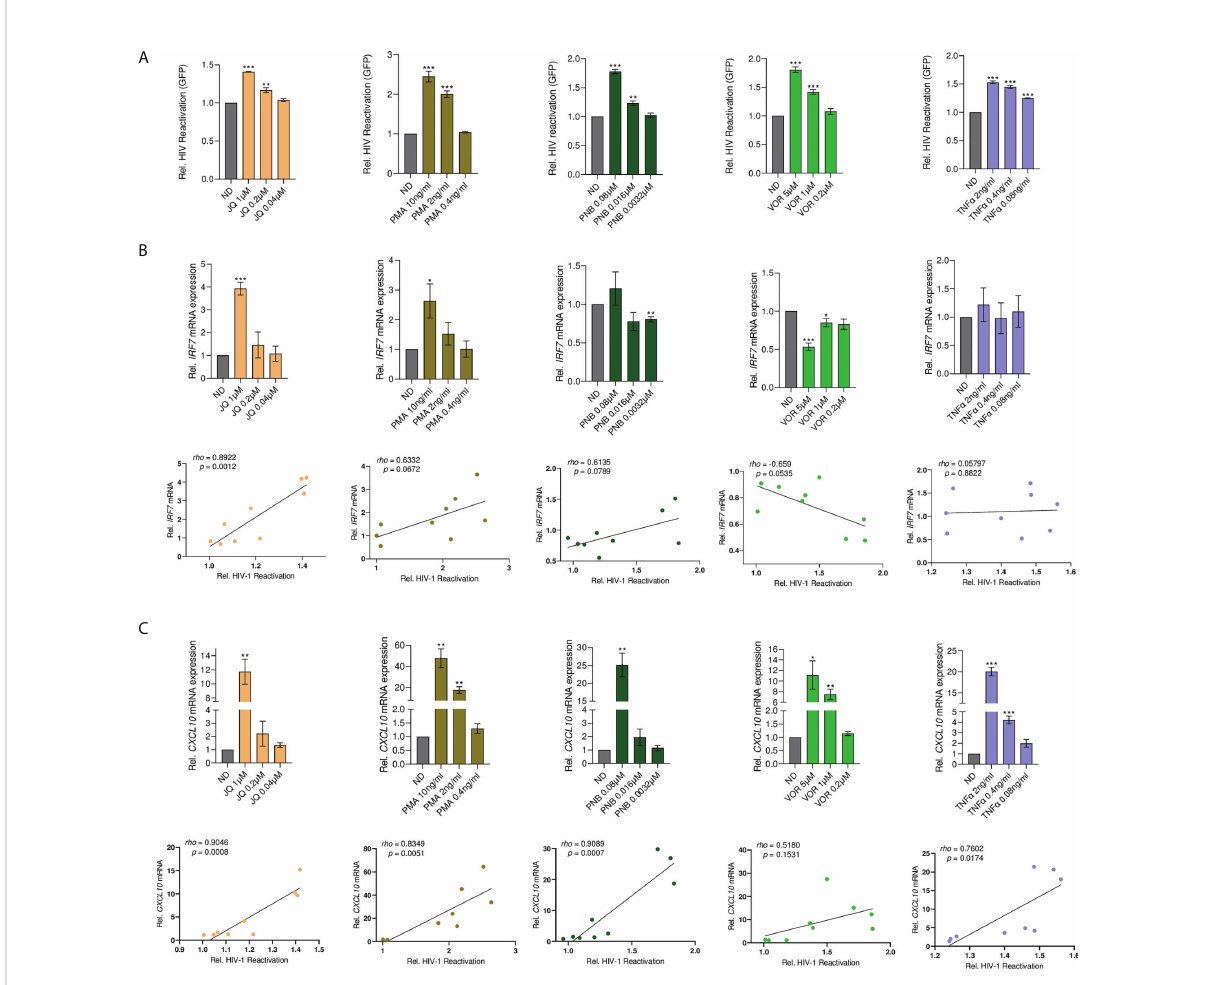
FIGURE 6 Latency reactivation by common LRAs positively correlates with the induction of ISG. (A) Dose-response latency reversal activity by distinct well-described LRAs in a model of HIV-1 latency (HL-HIG). Bar plots represent relative HIV-1 reactivation normalized to the untreated control (ND). (B) Top panels, IRF7 gene expression upon treatment with the indicated LRAs. Relative mRNA expressions are expressed as fold-change differences in expression of gene-of-interest relative to GAPDH gene. Bottom panels, Pearson correlation plots of HIV latency reversal activity versus IRF7 gene expression. (C) Top panels, CXCL10 gene expression upon treatment with the indicated LRAs. Relative mRNA expressions are expressed as fold-change differences in expression of gene-of-interest relative to GAPDH gene. Bottom panels, pearson correlation plots of HIV latency reversal activity versus CXCL10 gene expression. All statistical comparisons were performed with Student ’ s t tests. *p<0.05; **p<0.01; ***p<0.001. Data are expressed as mean ± SD of at least three independent